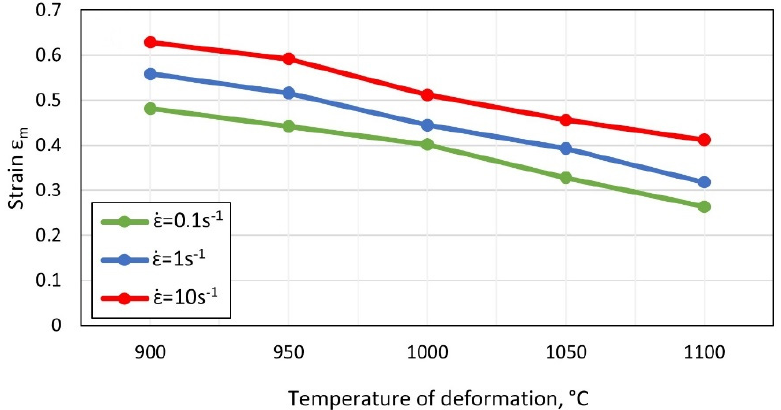
Figure 3. Impact of temperature and strain rate on the value of deformation ε m . Along with lowering the temperature and increasing the strain rate, an increase in the value of strain ε m was observed. For a strain rate of 0.1 s − 1 , the reduction in the plastic deformation temperature from 1100 ◦ C to 900 ◦ C caused an increase in the maximum yield stress σ m from approx. 78 MPa to 160 MPa, and deformation ε m from 0.26 to 0.48. The reduction in the deformation temperature of the compression temperature at the rate of 1 s − 1 influenced the increase in σ m from 117 MPa to 194 MPa. For the parameters described, there was a simultaneous increase in ε m from 0.32 to 0.56. During the compression of steel with the rate of 10 s − 1 at 900 ◦ C, the value of σ m was 221 MPa, with ε m equal to 0.63. With the increase in the deformation temperature to 1100 ◦ C, the value of σ m decreased to 143 MPa, with ε m equal to